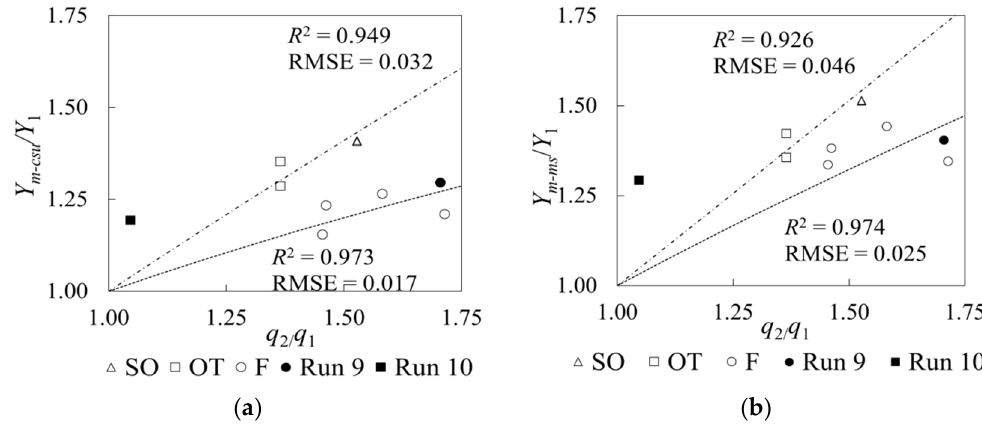
Figure 4. Effect of flow contraction on additional scour components using ( a ) Colorado State University (CSU) and ( b ) Melville-Sheppard (M/S) equations.